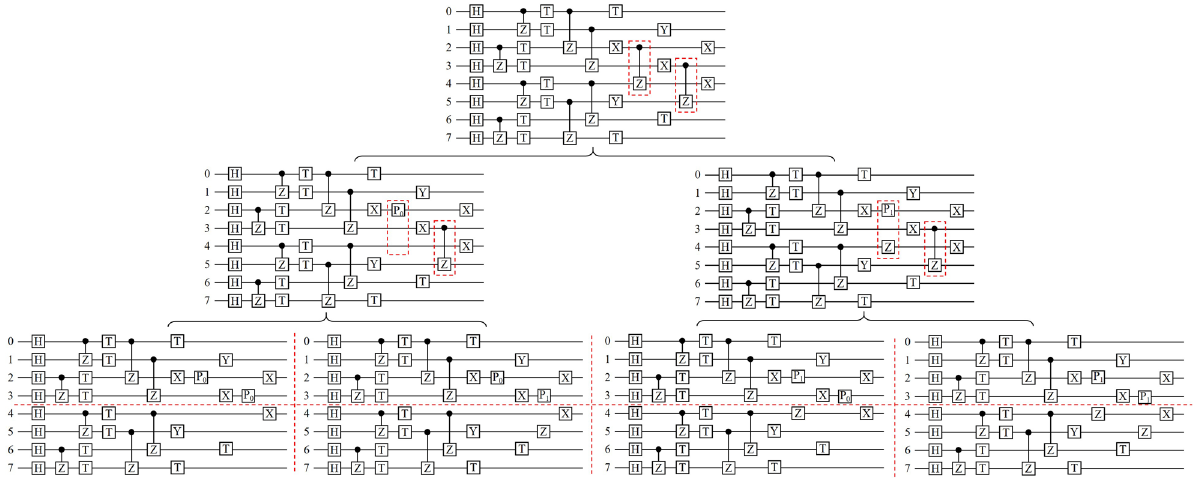
Figure 1. The partition scheme for a quantum circuit with 8 qubits and 8 depths 10 . The first line shows the original circuit. In the second line, the CZ gate in 7th depth is decomposed to projection and single-qubit Z gate, then the original circuit converts to two circuits. In the third line, the CZ gate in 8th depth is further decomposed, and the number of circuit is again double. In each of the final 4 circuits, the upper and lower parts is untangled, and they can be simulated independently.